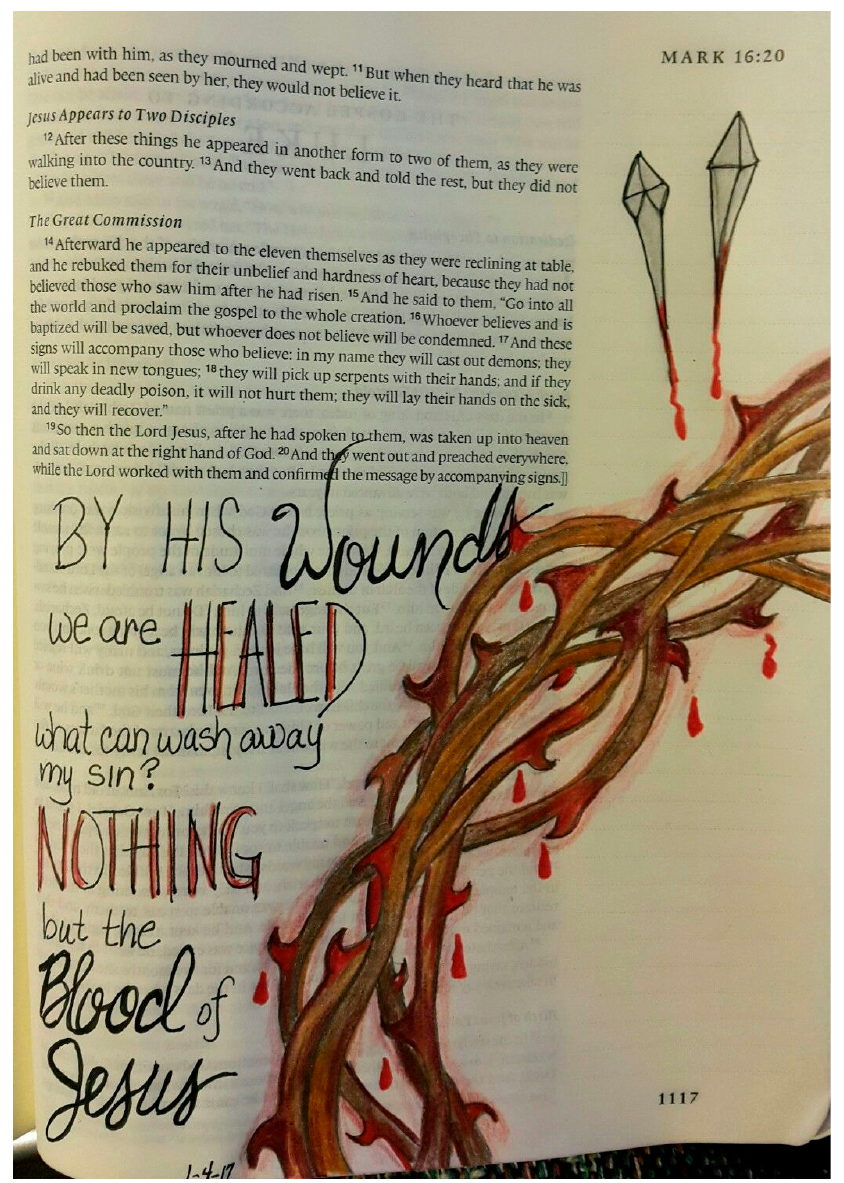
Figure 3. “By His Wounds We Are Healed” by Charlotte Parrack (with kind permission of the journaler).